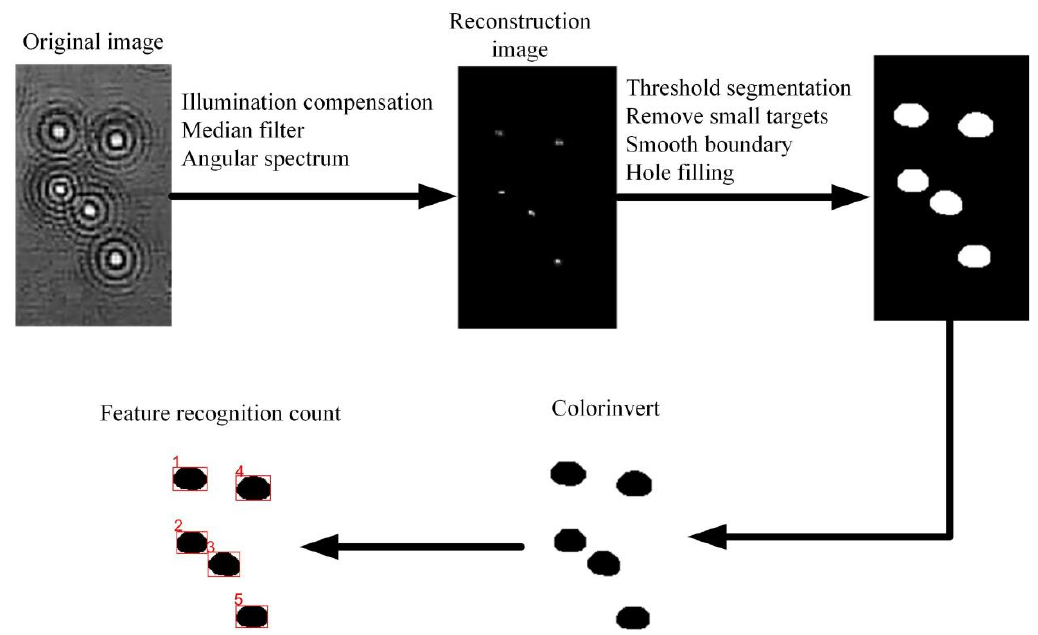
Figure 4. Spore diffraction image processing and counting.